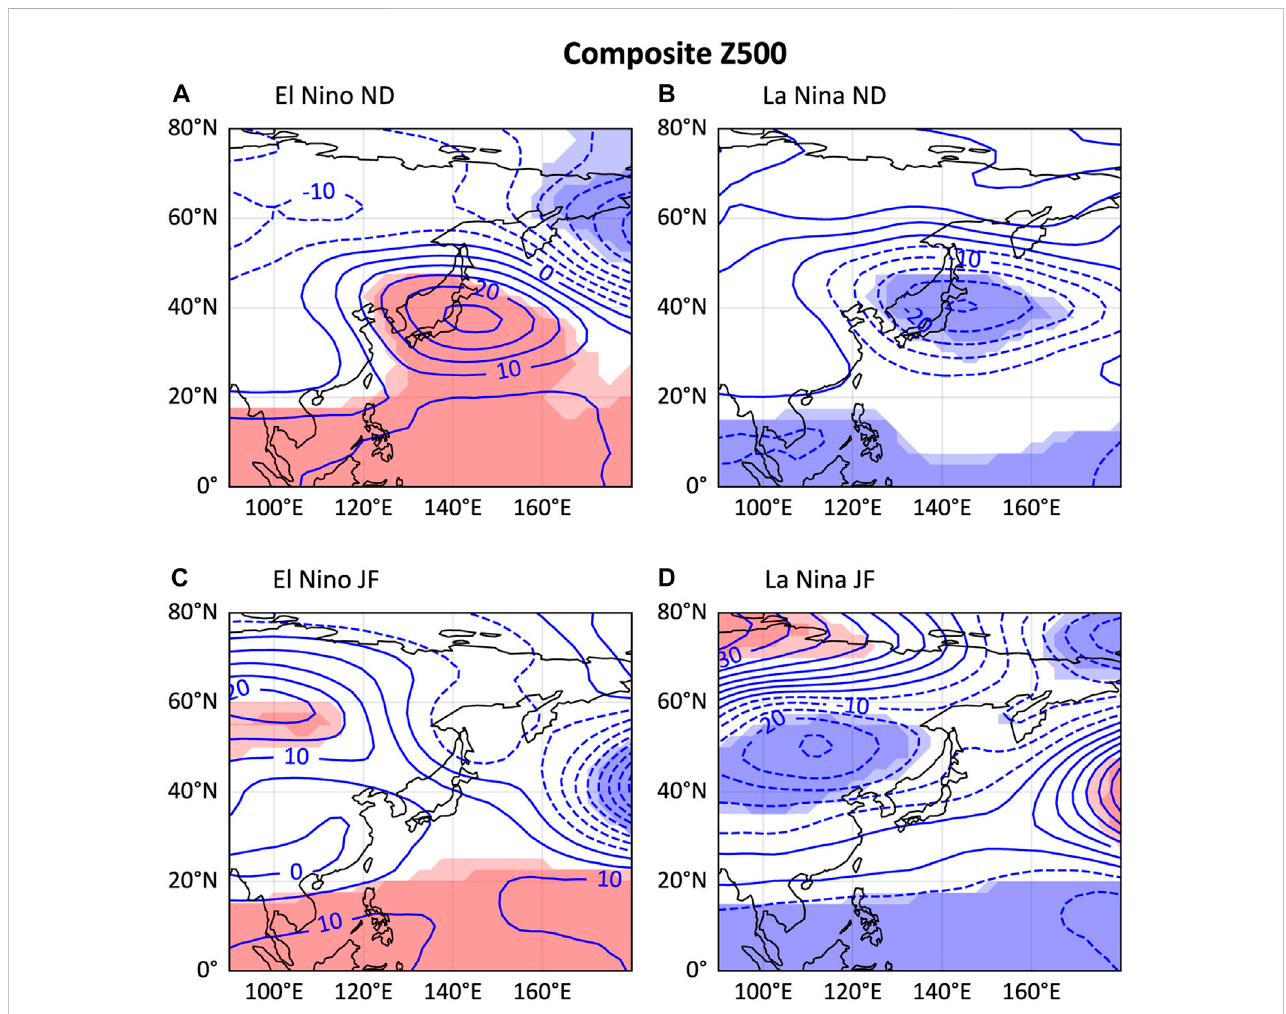
Compositepatterns of (A,B) Nov-Dec-averaged 500 hPa anomalous geopotential height (Z500,unit= gpm, contourinterval =5) in El Niñoand La Niña winters during 1979 – 2021, respectively. (C, D) Are the same as in (A, B) , but for Jan – Feb-averaged Z500 anomalies. Red (Blue) shading indicates positive (negative) anomalies that exceed the 95% con fi dence level. The list of El Niño and La Niña events can be found in NOAA ’ s Climate Prediction Center https://